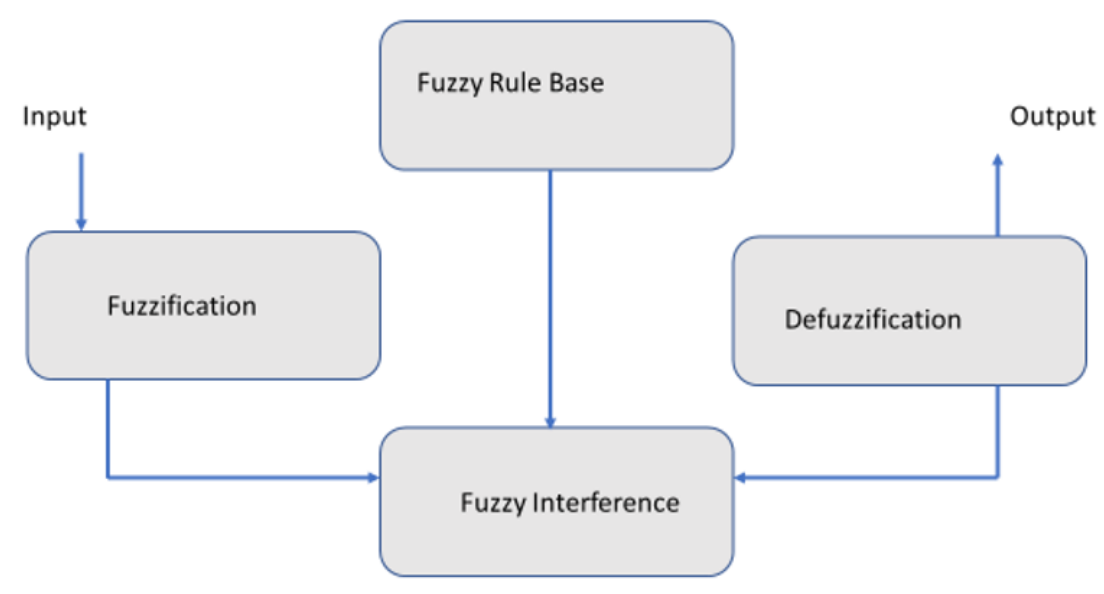
Figure 1. Architecture of Fuzzy System.